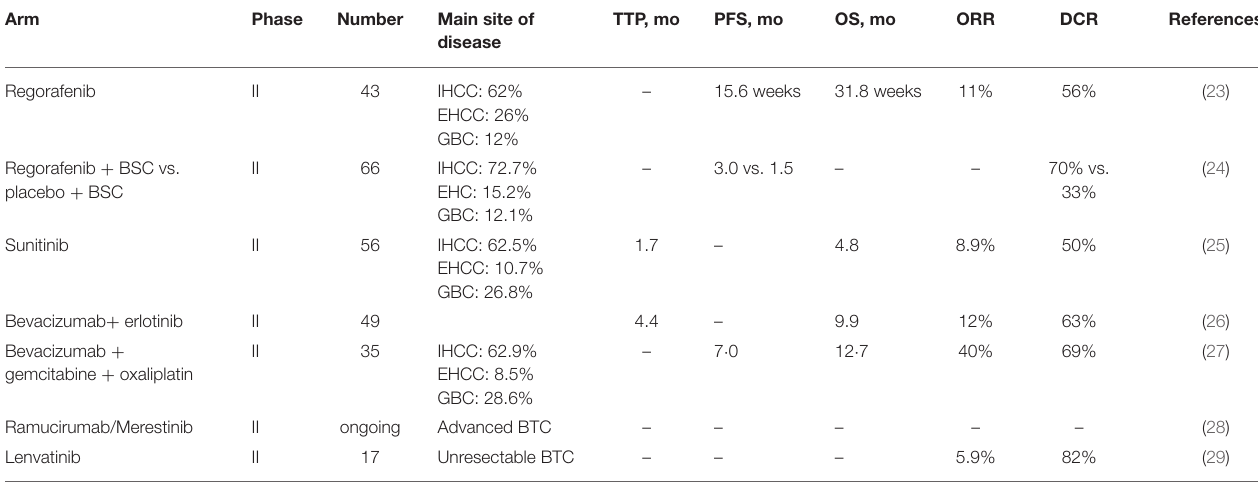
TABLE 2 | Clinical trials targeting VEGF pathway for metastatic biliary tract cancer. Arm Phase Number Main site of